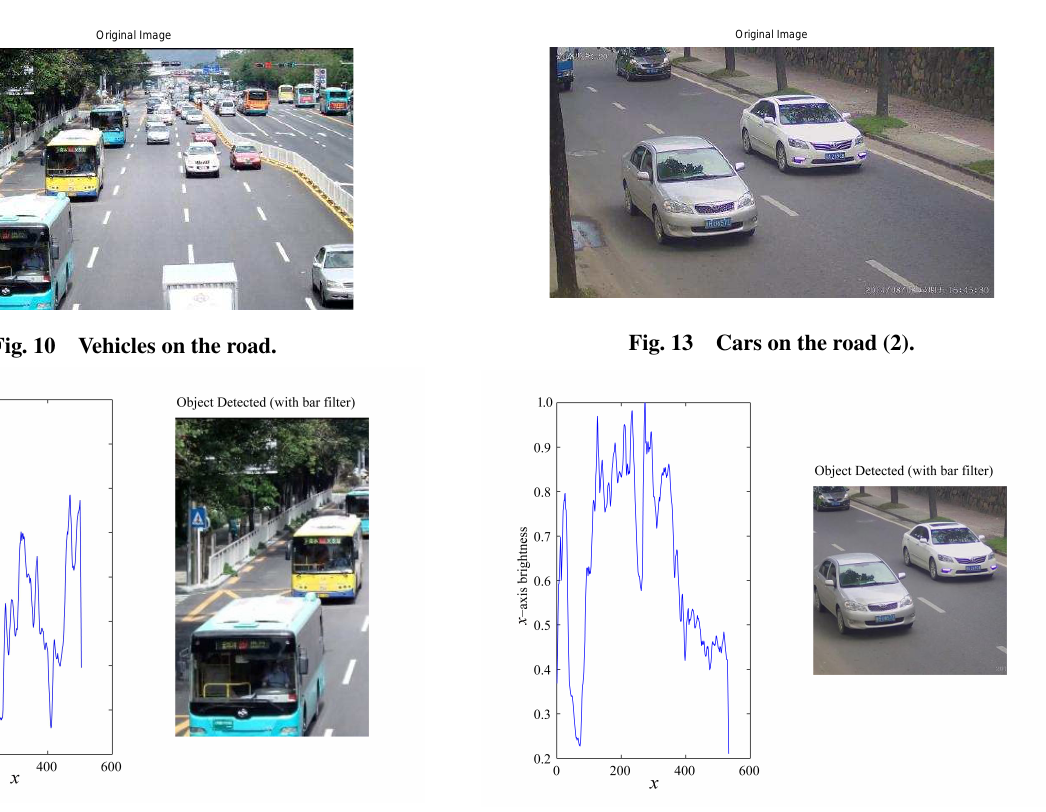
Fig. 14 Horizontal axis’ brightness values and selected cars (with bar filter) according to Fig. 13.